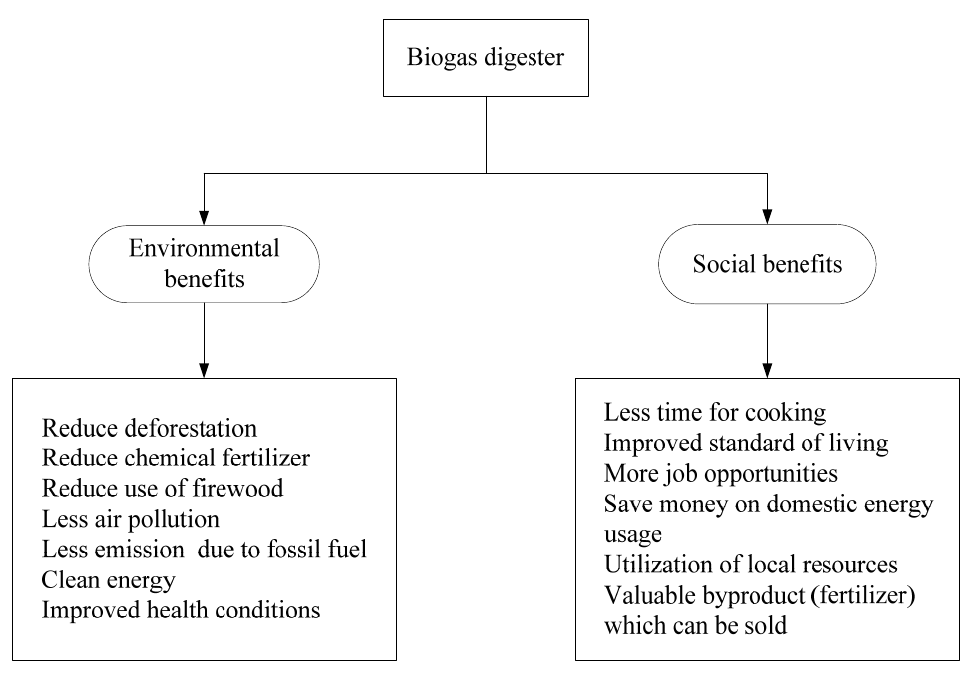
Figure 5. Environmental and social benefits in using biogas